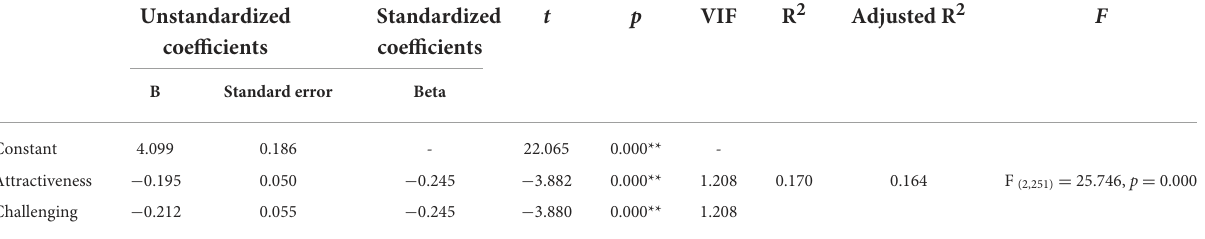
TABLE 5 Stepwise regression results of social anxiety and environmental factors.